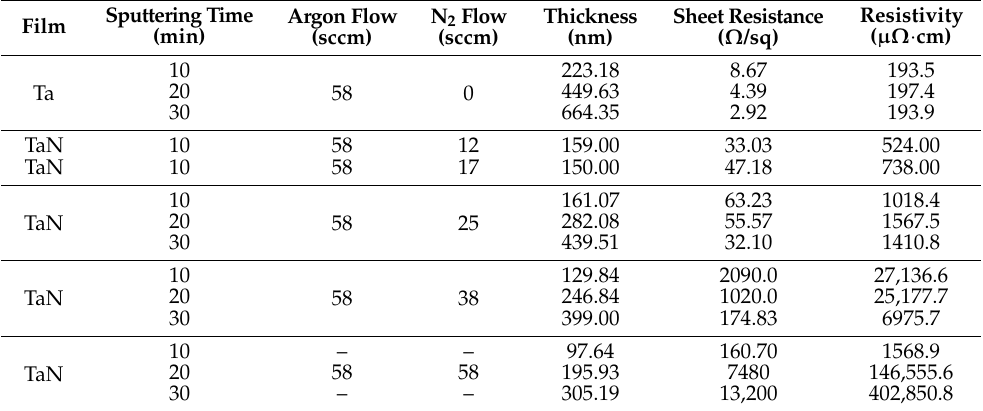
Table 1. The thickness, sheet resistance, and resistivity of Ta(N) film deposited with different N 2 flow rates and different sputtering times.